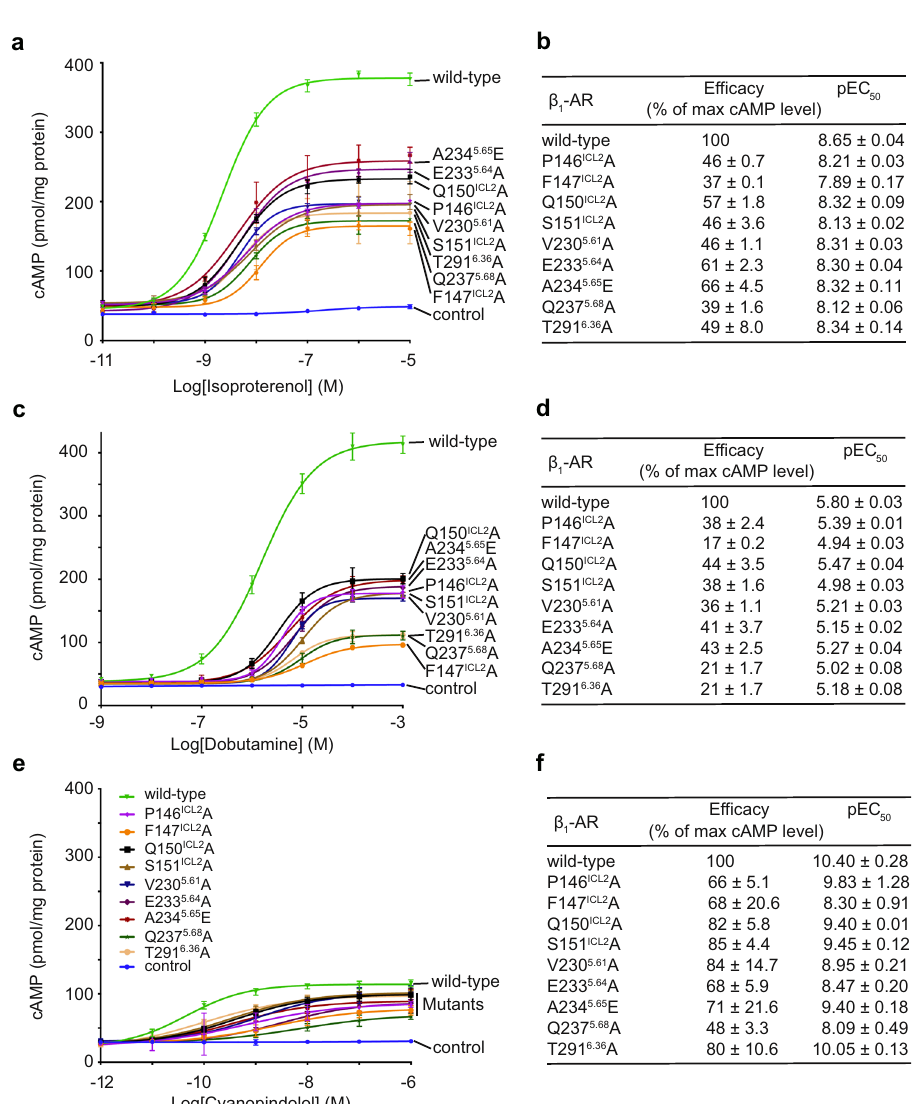
Fig. 5 Functional studies of the signaling from β 1 -ARs initiated by a full agonist, a partial agonist, or a very weak partial agonist. a , b Effects of receptor mutations on isoproterenol-induced cAMP responses. a Dose – response data from cells expressing different β 1 -AR constructs after stimulation with isoproterenol. b Summary of the ef fi cacy (the maximum cAMP level of a mutant receptor/the maximum cAMP level of the wild-type receptor) and EC 50 values based on the cAMP assay data shown in ( a ). a and b are adapted from 20 and used here for direct comparison. c , d Effects of mutations on dobutamine-induced cAMP responses. c Dose – response data from cells expressing different β 1 -ARs after stimulation with dobutamine. d Summary of the ef fi cacy and EC 50 values based on the cAMP assay data shown in ( c ). e , f Effects of mutations on cyanopindolol-induced cAMP responses. e Dose – response data from cells expressing different β 1 -ARs after stimulation with cyanopindolol. f Summary of the ef fi cacy and EC 50 values based on the cAMP assay data shown in ( e ). Data are shown as mean ± SD of three experiments. The analysis was done using the log(agonist) vs. response function of Prism 8 (GraphPad). When comparing with the wild-type receptor, all mutant receptors showed signi fi cant difference with p values < 0.05 (Student ’ s t -test, two-sided). The color keys for the receptor mutants are the same for ( c ) and ( e ), and are displayed in ( e ). Source data are provided as a Source Data fi